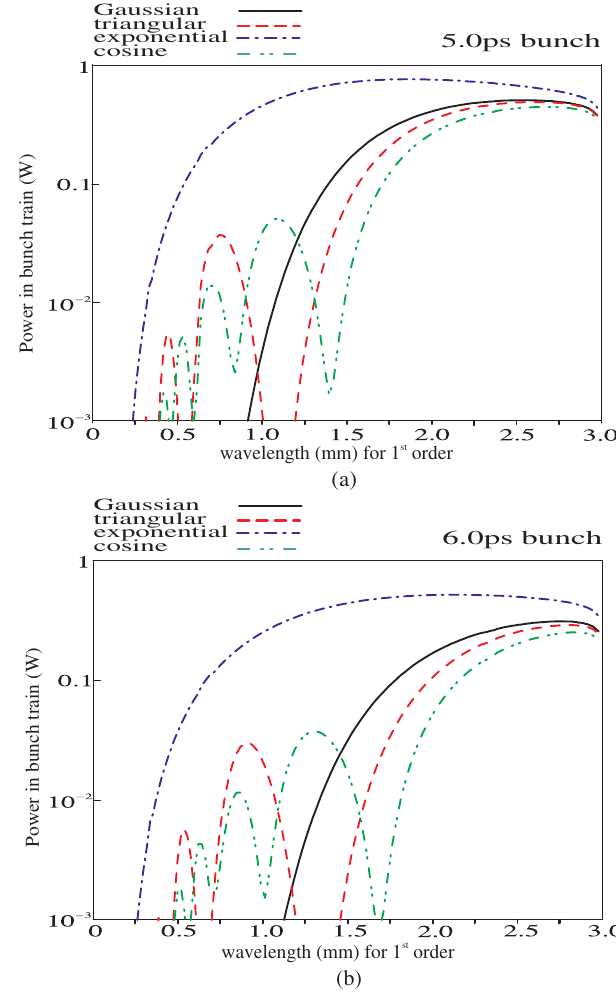
FIG. 8. (Color) Plots of the expected wavelength distribution of Smith-Purcell radiation for a number of bunch profiles. The bunch length (90% of particles) has been taken to be equal to 5 ps in (a) and 6 ps in